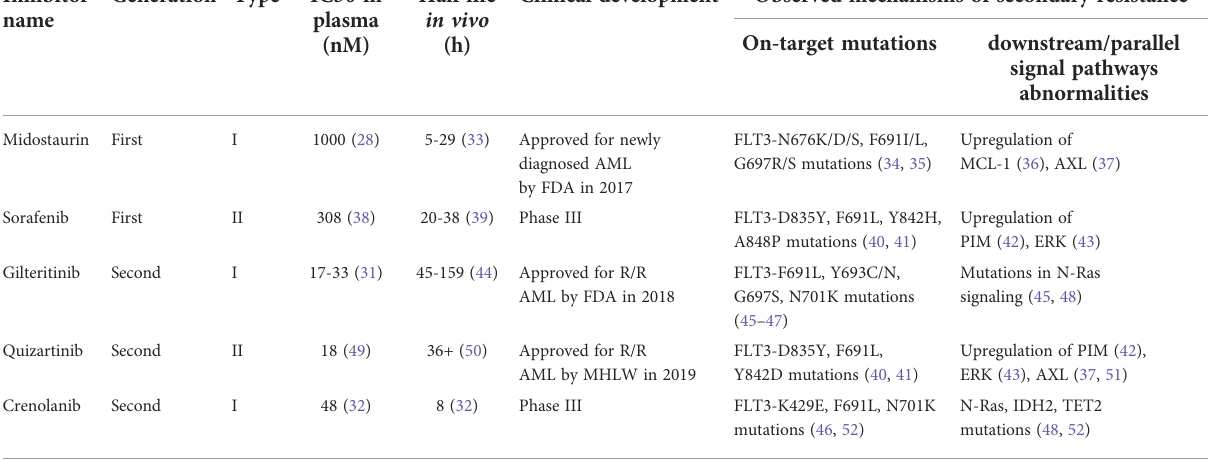
TABLE 1 Established FLT3 inhibitors and